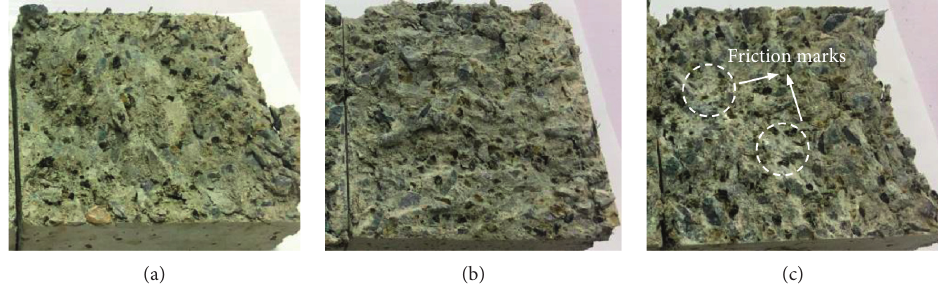
Figure 4: The influence of axial compression ratio on the shear failure section of rubber fiber concrete. (a) 0% f f c A s